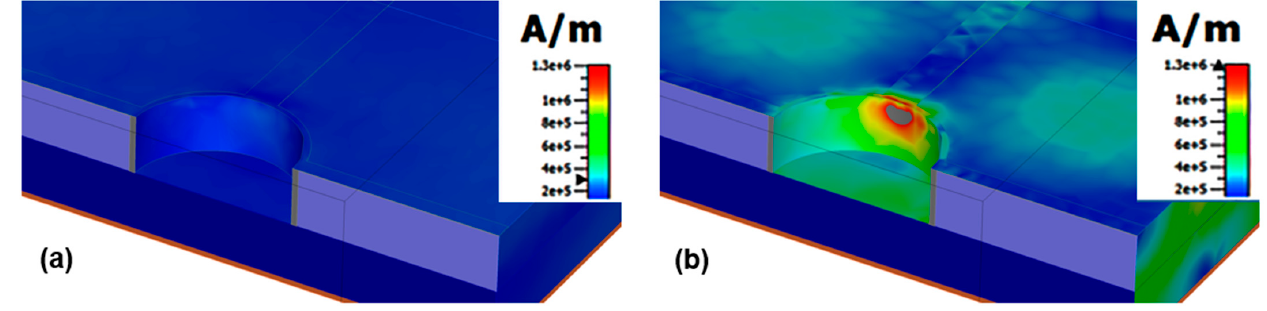
Figure 7. ( a ) H- fi eld mapping for λ res = 900 nm, ( b ) H- fi eld distribution for λ res = 949 nm. Figure 7. ( a ) H-field mapping for λ res = 900 nm, ( b ) H-field distribution for λ res = 949 nm.